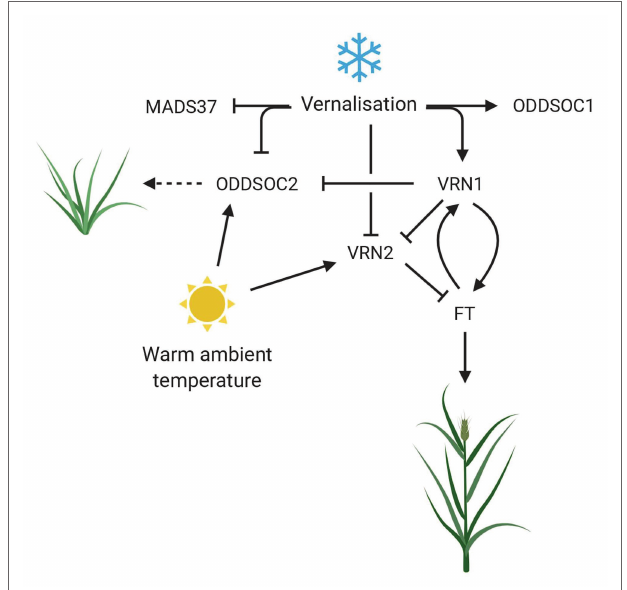
FIGURE 2 | The role of FLC genes in the response to temperature in temperate cereals with a vernalization requirement. Vernalization represses the activities of floral repressors ODDSOC2 and VRN2, while promoting the upregulation of VRN1 . VRN1 is required to maintain the repression of ODDSOC2 and VRN2 while promoting the flowering time gene FT , creating a positive feedback loop to lock in the floral transition. Warm ambient temperature during the vernalization process results in the upregulation of floral repressors to coordinate reproductive development with the most optimal environmental conditions. Dashed arrow implies function not confirmed. MADS37 and ODDSOC1 are included but their function is still unknown. Created with